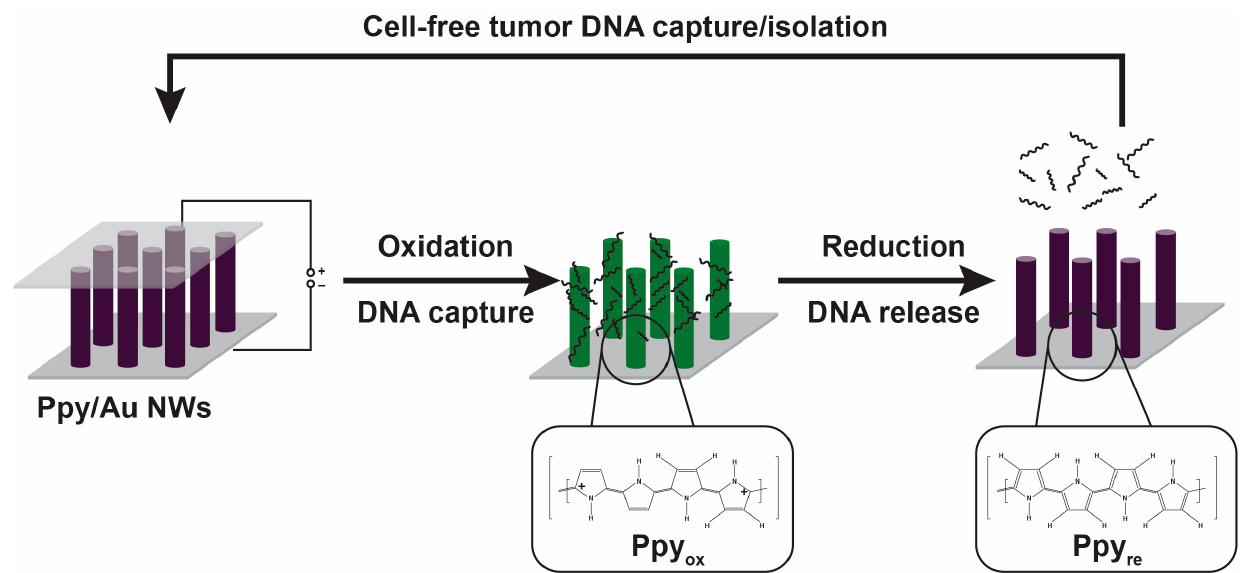
Figure 3. Application of Ppy-coated gold nanowires (Ppy/AuNWs) for the isolation and capture of tumor cfDNA based on the oxidoreduction features under electric fields. Reused with permission from Ref. [36]. ©2016 the authors (open access). Published by Ivyspring International Publisher. Molecular imprinting is another promising and fast-growing bio-isolation technique.